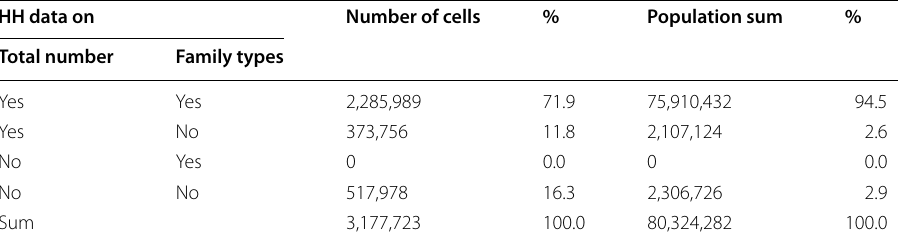
Table 2 Coverage of attributes in Census HHs data (Statistisches Bundesamt 2011a) in populated cells HH data